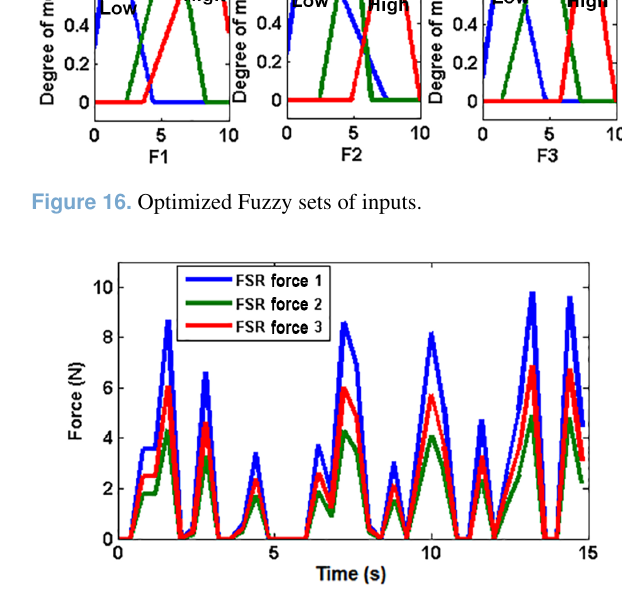
Figure 17. Contact force on phalanges